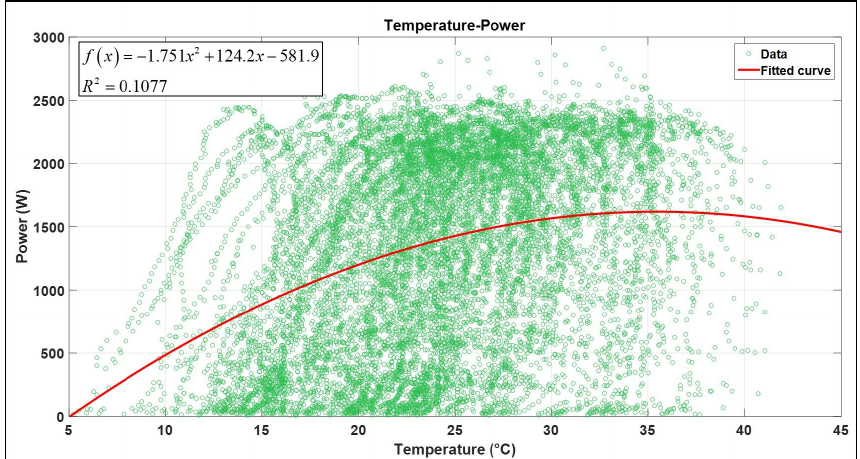
Figure 5. The Power vs. Temperature of